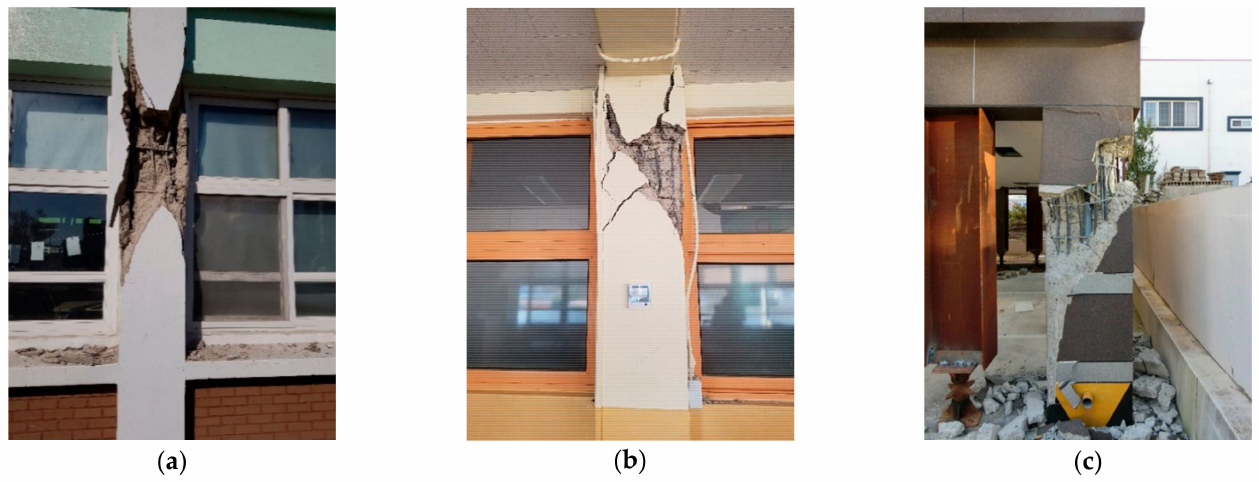
Figure 1. Damaged buildings after the 2017 Pohang Earthquake: ( a ) RC school building; ( b ) RC public building; ( c ) piloti